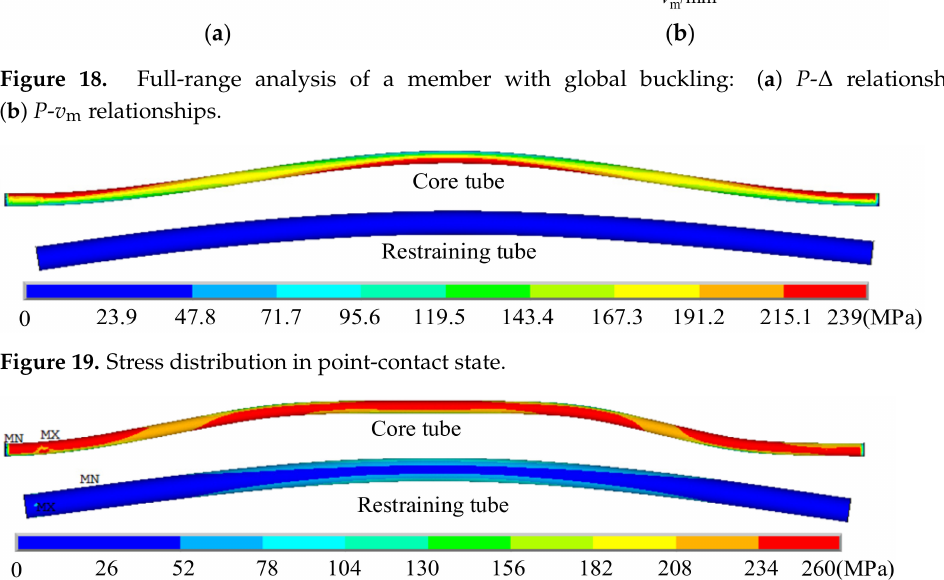
Figure 20. Stress distribution in line-contact state.